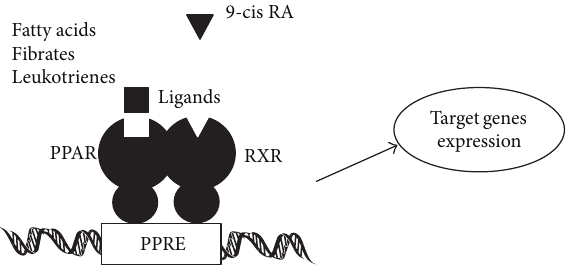
Figure 2: Schematic depiction of the model of mechanism of PPAR action. Similar to other nuclear hormone receptors, PPARs act as a ligandactivatedtranscriptionfactor.PPARsinresponsetotheligand binding heterodimerize with RXR and bind PPRE DNA sequences in thepromoters of target genes, which are often involved in the lipid metabolism.Notethatsomecriticalmoleculeshavebeenomittedfor clarity. Figure 3: A hypothetical schematic implication of some of the